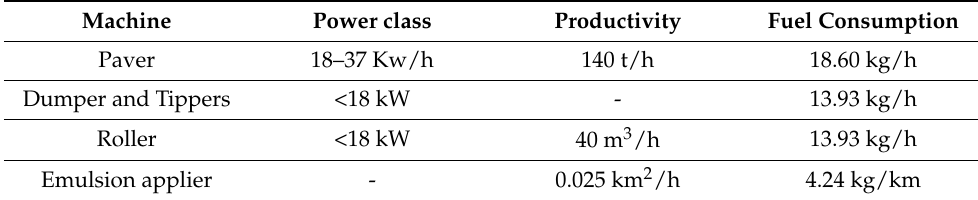
Table 5. Machinery